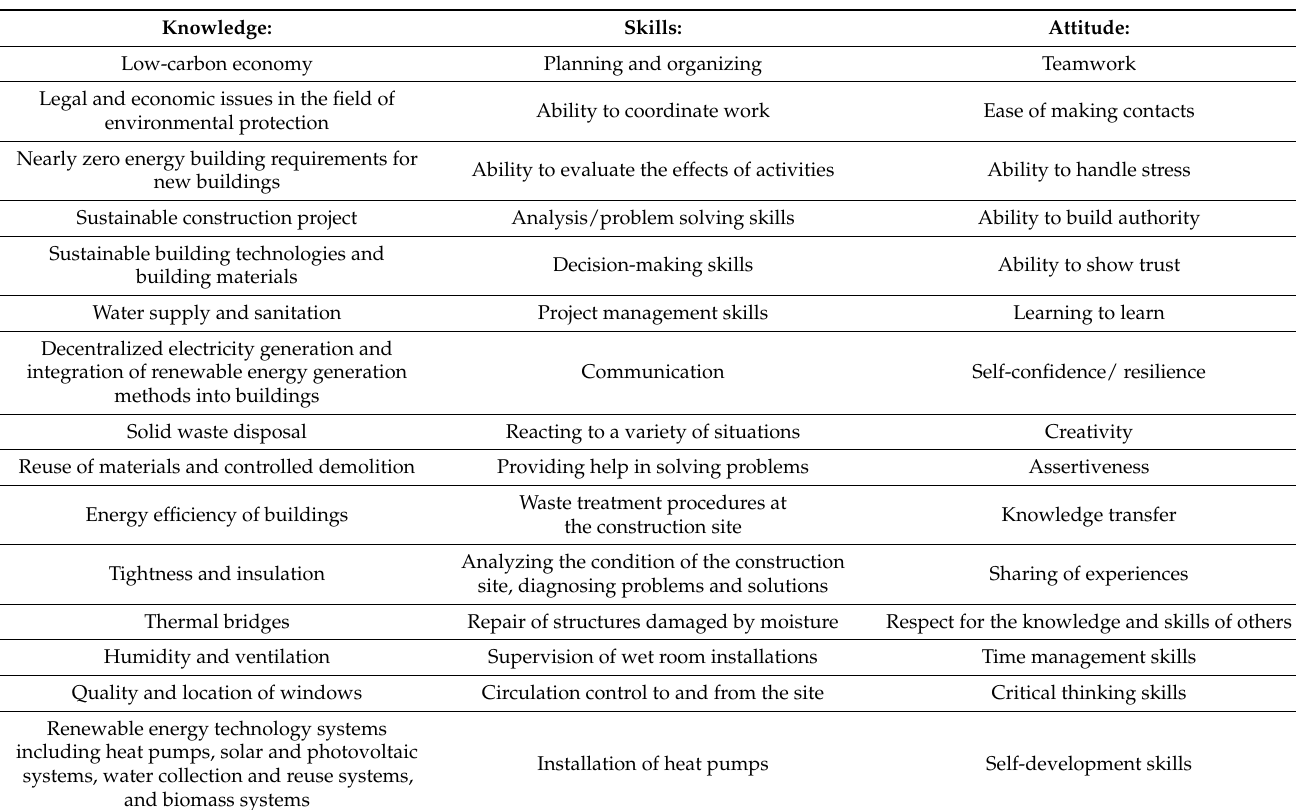
Table 2. List of competencies of employees in the construction sector, including competencies related to the low-carbon economy. Knowledge: Skills: